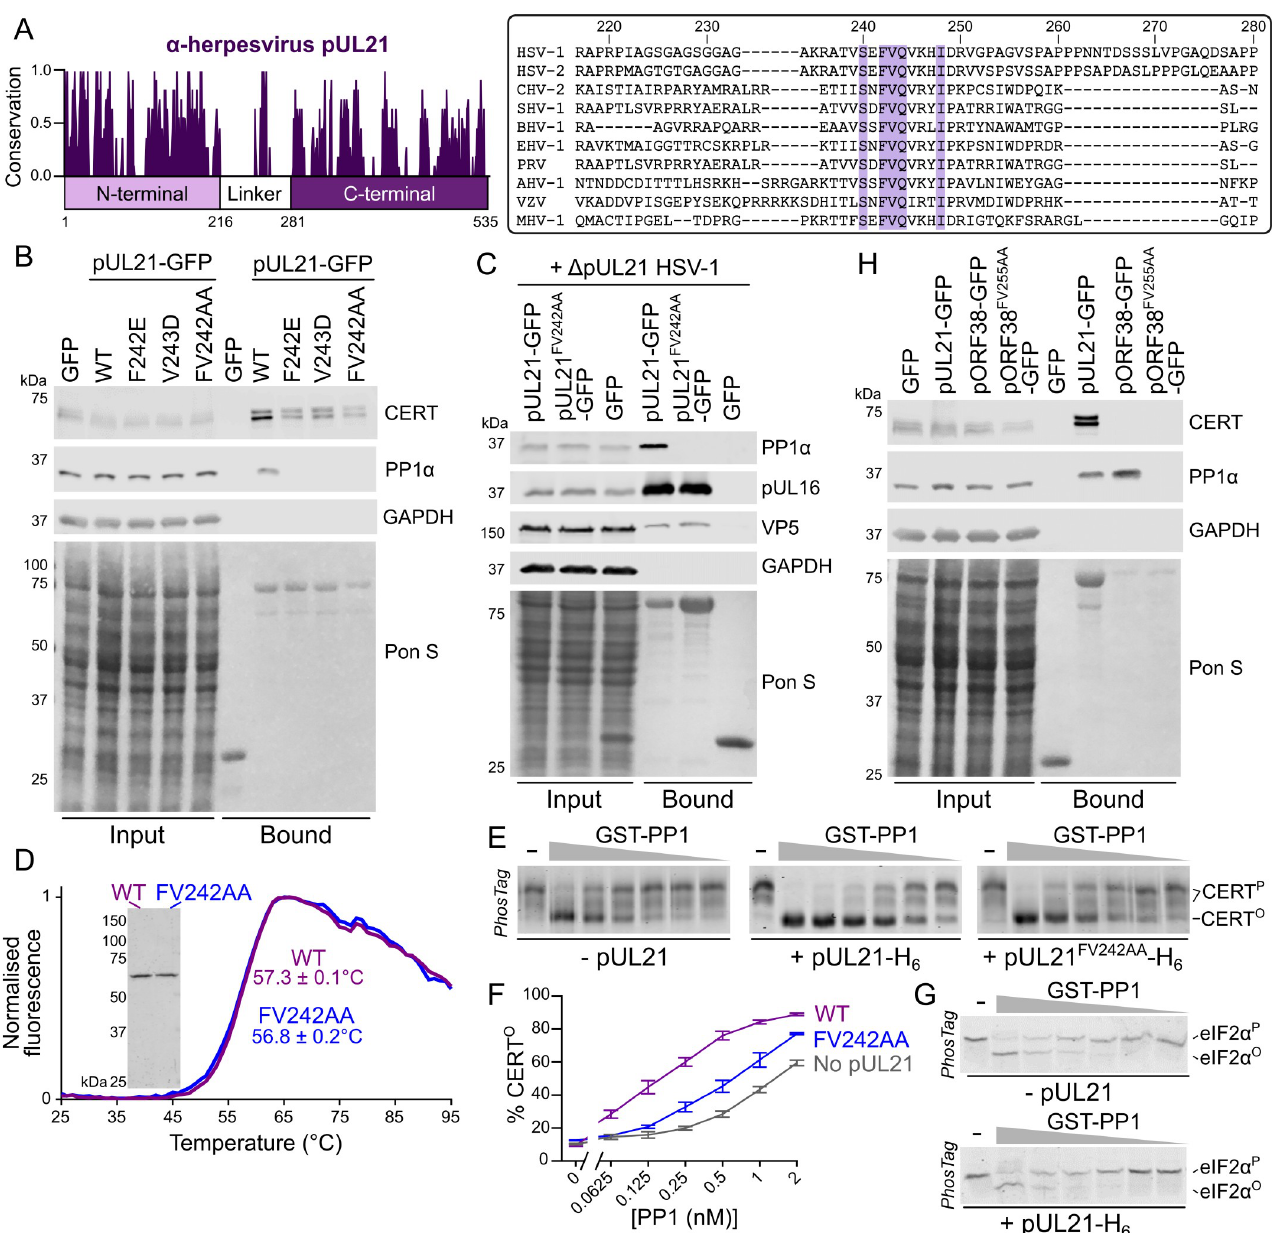
Fig 3. pUL21 recruits PP1 via a conserved motif in the linker region to accelerate CERT dephosphorylation. ( A ). Conservation of pUL21 across Alphaverpesvirinae . The following sequences were aligned using ClustalW and conservation calculated using Jalview (Abbreviation and Uniprot ID are shown in parentheses): HSV-1 (HSV1, P10205), HSV-2 (HSV2, G9I242), cercopithecine herpesvirus 2 (CHV2, Q5Y0T2), saimiriine herpesvirus 1 (SHV1, E2IUE9), bovine alphaherpesvirus 1 (BHV1, Q65563), equine herpesvirus 1 (EHV1, P28972), pseudorabies virus (PRV, Q04532), anatid herpesvirus 1 (AHV1, A4GRJ2), varicella-zoster virus (VZV, Q6QCT9), turkey herpesvirus (MHV1, Q9DPR5). Alignment across the linker region (residues 217–280 of HSV-1 pUL21) is shown with conserved residues highlighted. ( B ) HEK293T cells were transfected with plasmids expressing GFP, wild-type (WT) pUL21-GFP or pUL21-GFP with amino acid substitutions in the conserved motif. At 24 hours post-transfection the cells were lysed, subjected to immunoprecipitation using a GFP affinity resin, and captured proteins were subjected to SDS-PAGE and immunoblotting using the listed antibodies. Ponceau S (Pon S) staining of the nitrocellulose membrane before blocking is shown, confirming efficient capture of GFP-tagged proteins. ( C ) Plasmids expressing wild-type or mutant pUL21-GFP, or GFP alone, were transfected into HEK293T cells. At 24 hours post-transfection cells were infected with Δ pUL21 HSV-1 (MOI = 5). Cells were lysed 16 hours post-infection and subjected to immunoprecipitation, SDS-PAGE and immunoblotting as in ( B ). ( D ) Differential scanning fluorimetry of WT (purple) and FV242AA substituted (blue) pUL21-H 6 . Representative curves are shown. Melting temperatures ( T m ) is mean ± standard deviation (n = 3). Inset shows Coomassie-stained SDS-PAGE of the purified protein samples. ( E ) In vitro dephosphorylation assays using all-purified reagents. 0.5 μ M CERT was incubated with varying concentrations of GST-PP1 (two-fold serial dilution from 100–3.1 nM) in the absence or presence of 2 μ M pUL21-H 6 (WT or FV242AA) for 30 min at 30˚C. Proteins were